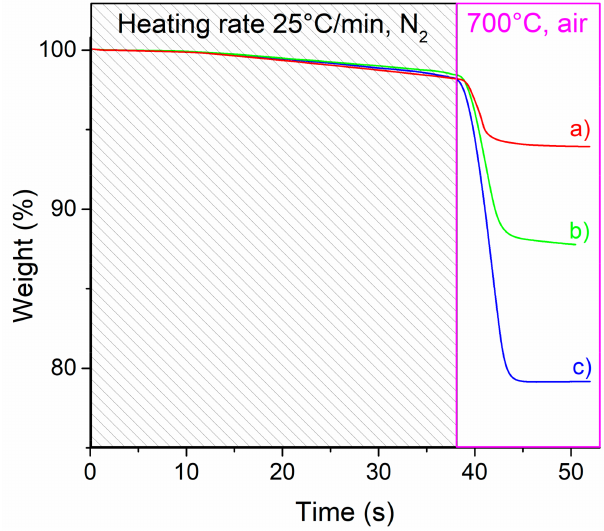
Figure 7. TGA curves obtained from a two-step measurement (heating under N 2 , and oxidation in air at 700 ◦ C) for the Fe-TITs contacted with C 2 H 4 at 750 ◦ C for 1 (cid:48) : (a) about 0.4 wt %; (b) 2 wt %, and (c) 3 wt % of Fe, respectively.